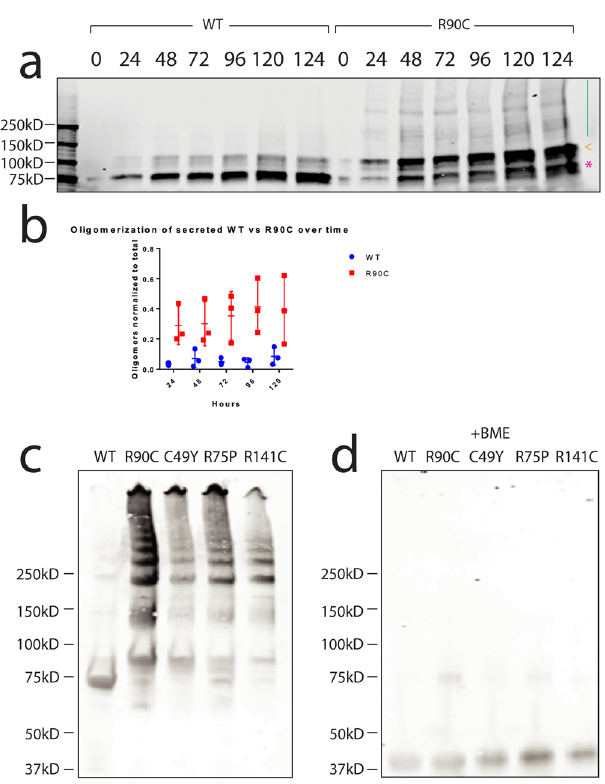
Fig. 1 Mutant NOTCH3 forms larger multimers compared to WT NOTCH3. On nonreducing SDS-PAGE gels, we observed higher-order multimerization (green line) of the R90C protein at various time points compared to WT protein, which only formed Fc dimers (pink * and orange <) ( a ). Comparison of R90C and WT multimer protein content to total Fc-NOTCH3 protein content from the media demonstrated the increased presence of R90C multimers in the media ( b ). R90C multimer content did not change with increased hours post-transfection ( b ). Center line represents the mean; upper and lower lines designate the standard deviation. Recombinant WT and mutant NOTCH3 protein were puri fi ed from stably transfected cell lines, as previously described 9 . All proteins were examined on nonreducing 4 – 20% SDS-PAGE gels (ThermoFisher). Protein laddering was observed for all mutants examined: R90C mutant, C49Y mutant, R75P mutant, and R141C mutant ( c ). Little to no laddering was observed for WT protein ( c ). The addition of ß-mercaptoethanol completely reduced multimers to the monomer level ( d ). Experiments were performed at least three times on distinct samples with similar